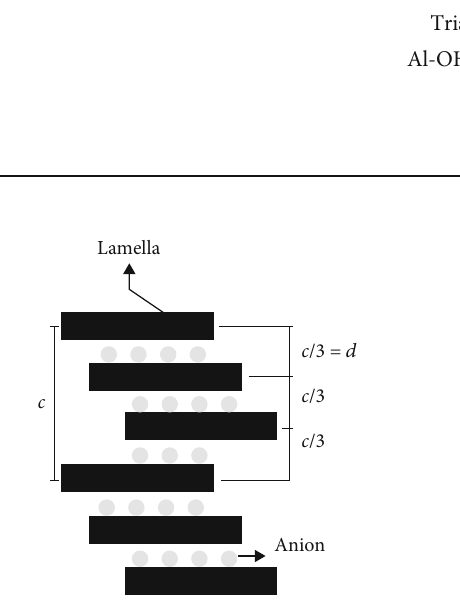
Figure 4: Relation between rhombohedral structure parameters for LDH. Adapted from Crepaldi and Valim (1998)